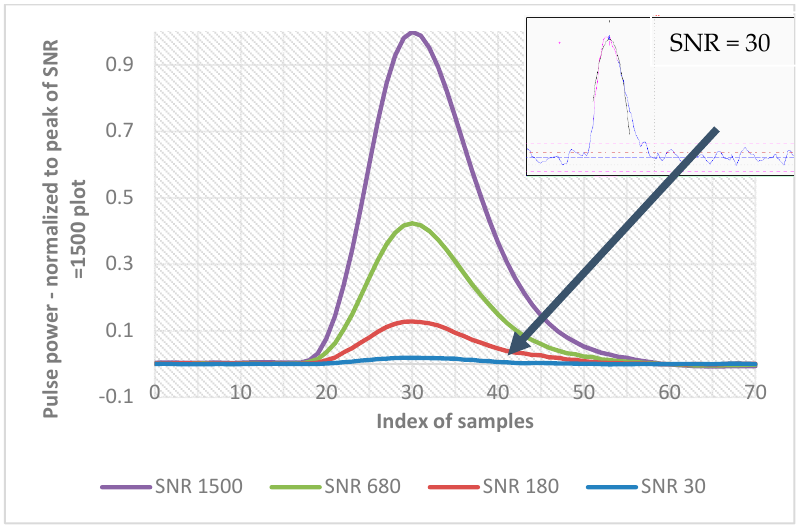
Figure 12. Examples of real life signals registered during measurements to different targets. All sig- nals were normalized to the peak value of the strongest signal. All plots are marked with values of their signal to noise ratios. In the window, the real recorded signal with SNR = 30 is shown.